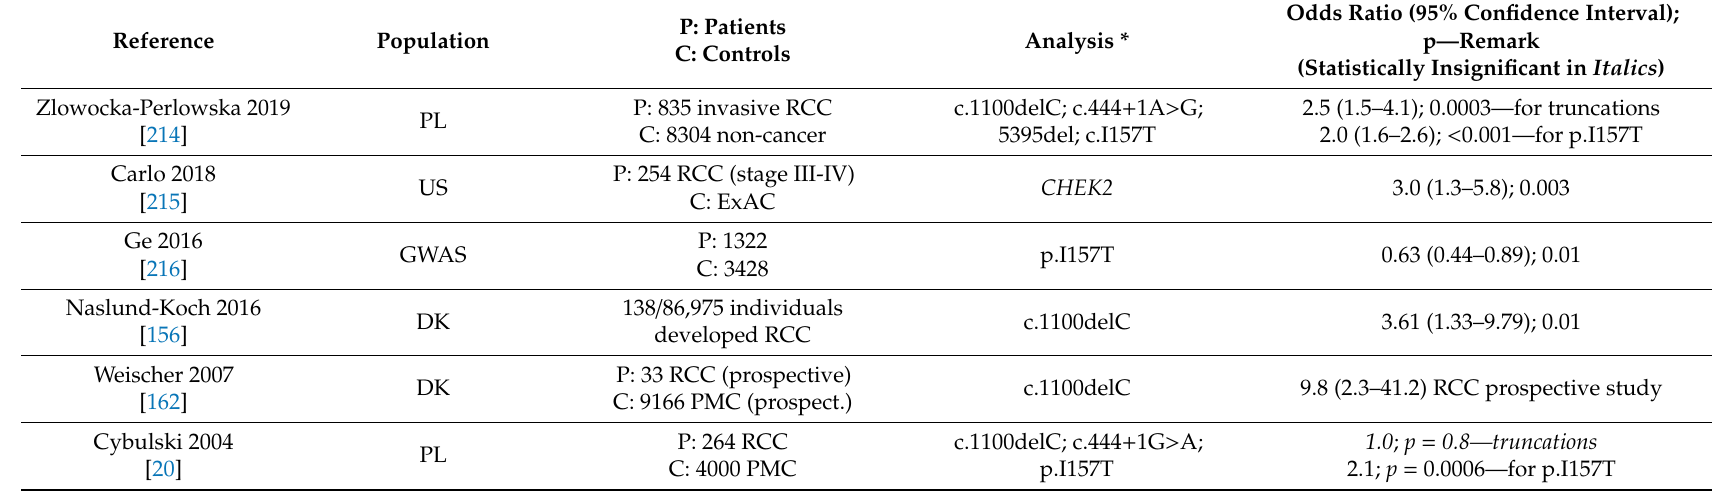
Table 3. Analyses of the entire CHEK2 coding sequence (separately or as a part of panel NGS) or analyses of specific variant(s) in renal cell carcinoma (RCC)